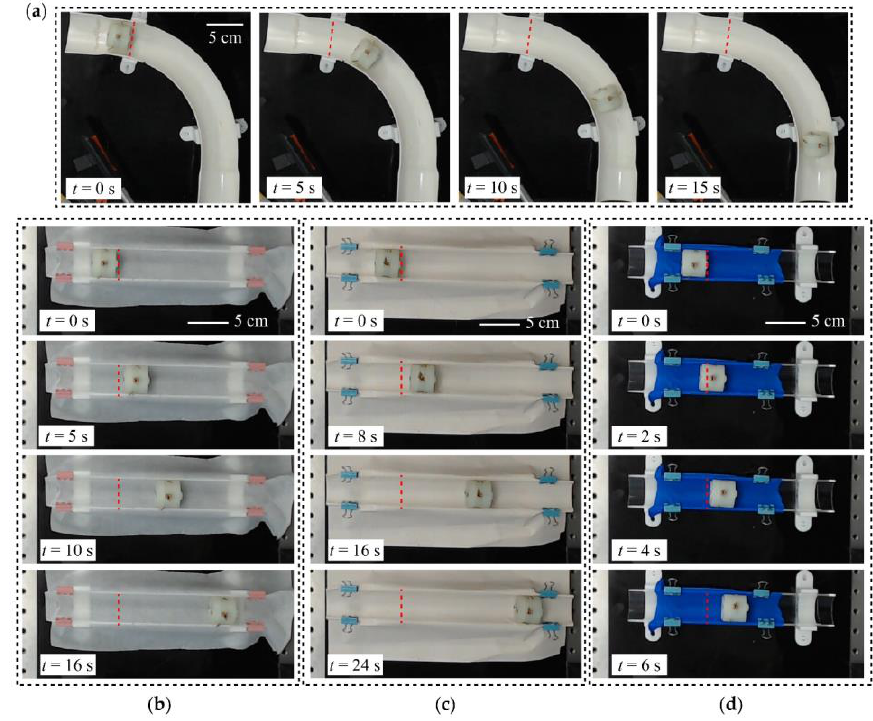
Figure 11. ( a ) Demonstration of the robot passing through a curved pipe; ( b ) Demonstration of the robot crawling through a non-sticking foil surface; ( c ) Demonstration of the robot crawling through a paper surface; ( d ) Demonstration of the robot crawling through a rubber surface. Table 2. Comparison of the proposed robot and existing vibro-impact crawling